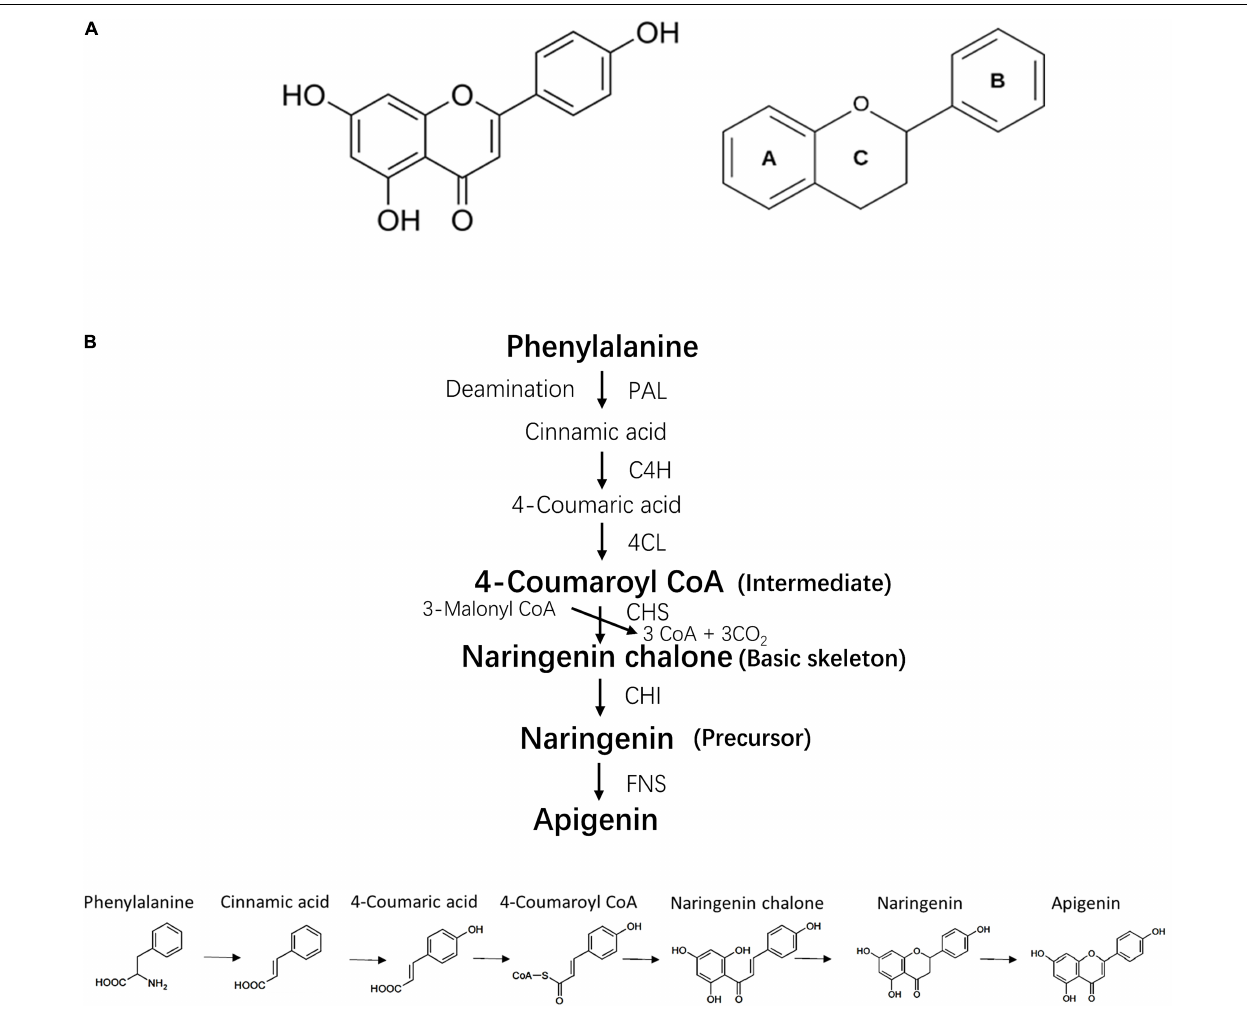
FIGURE 1 | Chemical structure and bio-synthesis of apigenin. (A) Chemical structure of apigenin and its basic skeleton. (B) The process of apigenin bio-synthesis. PAL, phenylalanine ammonia lyase; 4CH, cinnamate 4-hydroxylase; 4CL, 4-coumaroyl CoA ligase; CHS, chalcone synthase; CHI, chalcone isomerase; FNS, flavone